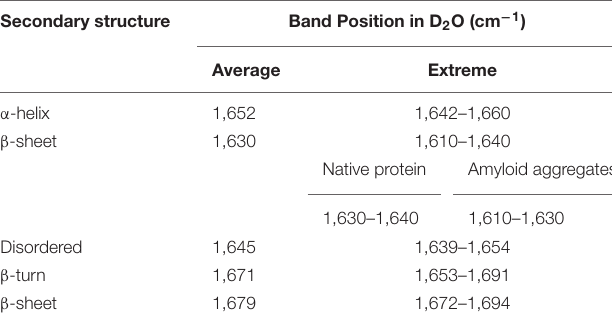
TABLE 1 | Assignment of amide I band positions to secondary structure components used in the study (Goormaghtigh et al., 1994; Zandomeneghi et al., 2004; Li et al.,